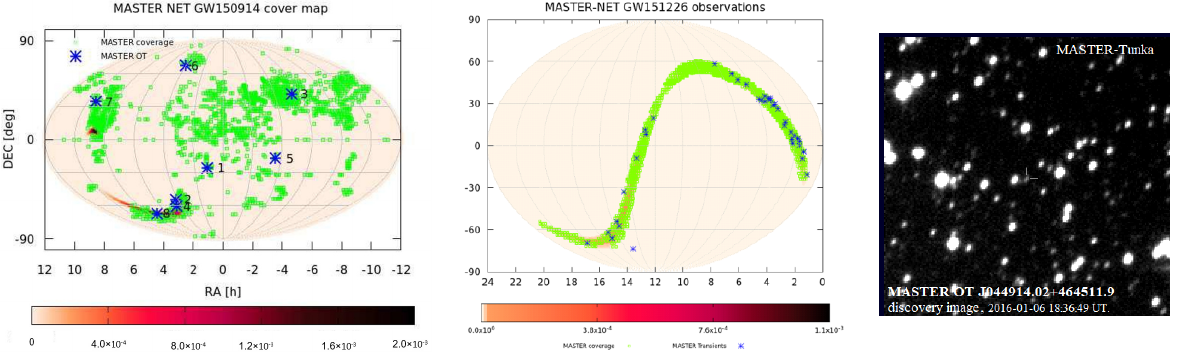
Figure 13. The complete maps of the sky survey carried out by MASTER Net for GW150914 ( left ) from 14 to 22 September 2015 and for the GW151226 ( middle ) for 2 weeks, with MASTER OT J044914.02+464511.9 ( right ) source discovered at the time of inspection at MASTER-Tunka.